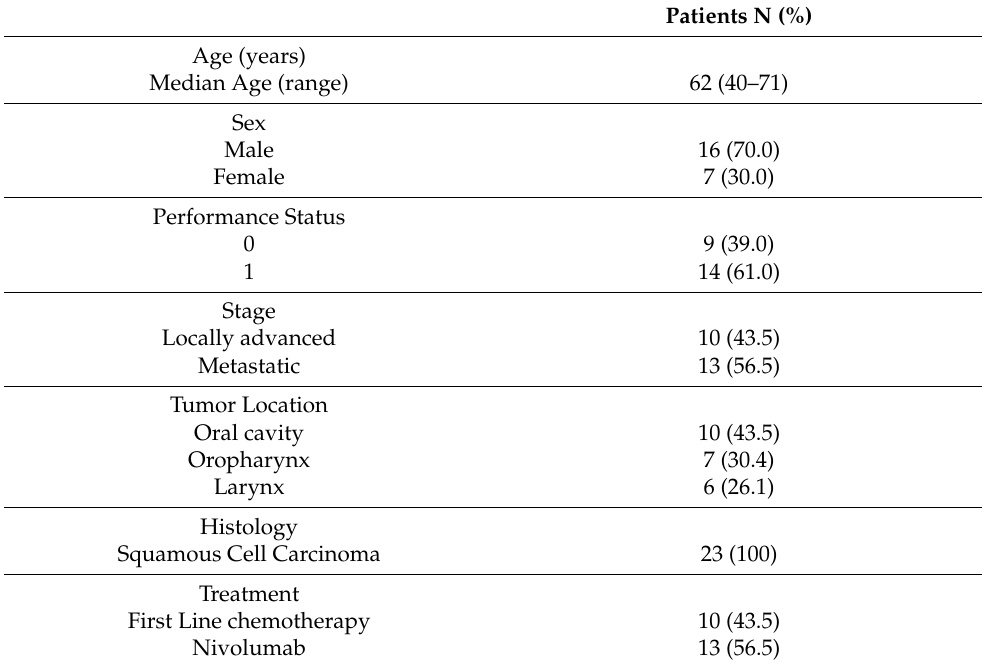
Table 1. Clinical and pathological characteristics.